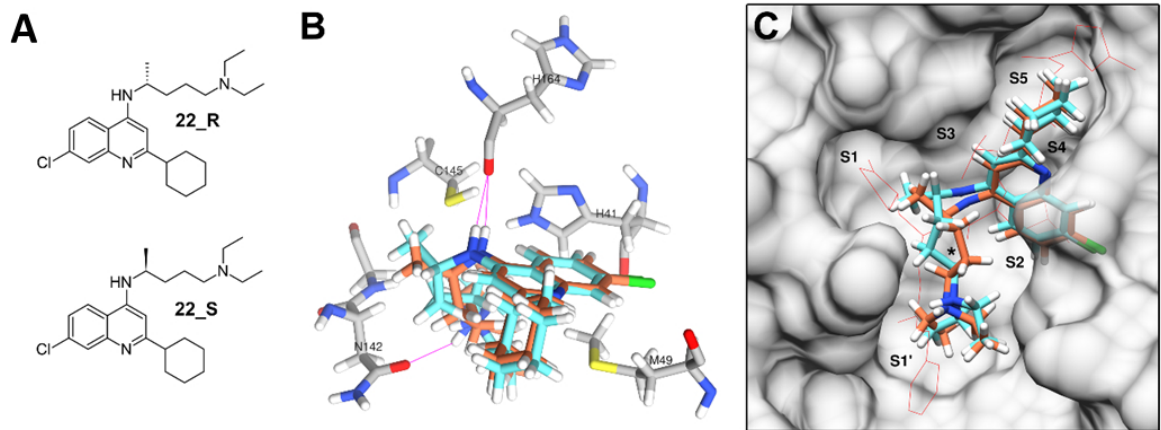
Figure 4. Docking poses predicted for compound 22. ( A ) Structure of stereoisomers 22_R and 22_S. ( B ) Orientation predicted for stereoisomers 22_R (cyan) and 22_S (orange) in the active site of M pro . Hydrogen bonds are represented by violet lines. ( C ) Extent of the orientation predicted for both stereoisomers in the active site, compared with the orientation of the N3 inhibitor (red wire). Approximate position of the His41-Cys145 catalytic dyad is indicated with